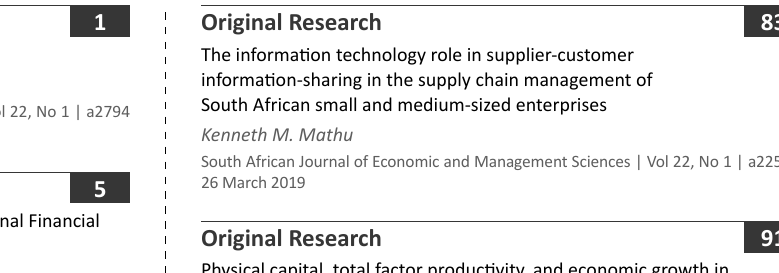
The information technology role in supplier-customer information-sharing in the supply chain management of